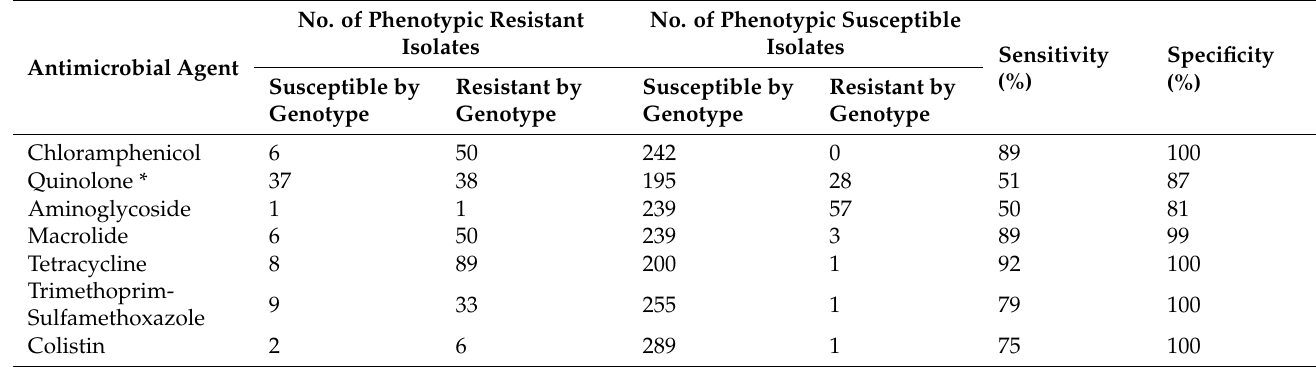
Table 3. Correspondence between drug-resistant phenotypes and genotypes of genes associated with resistance to seven classes of